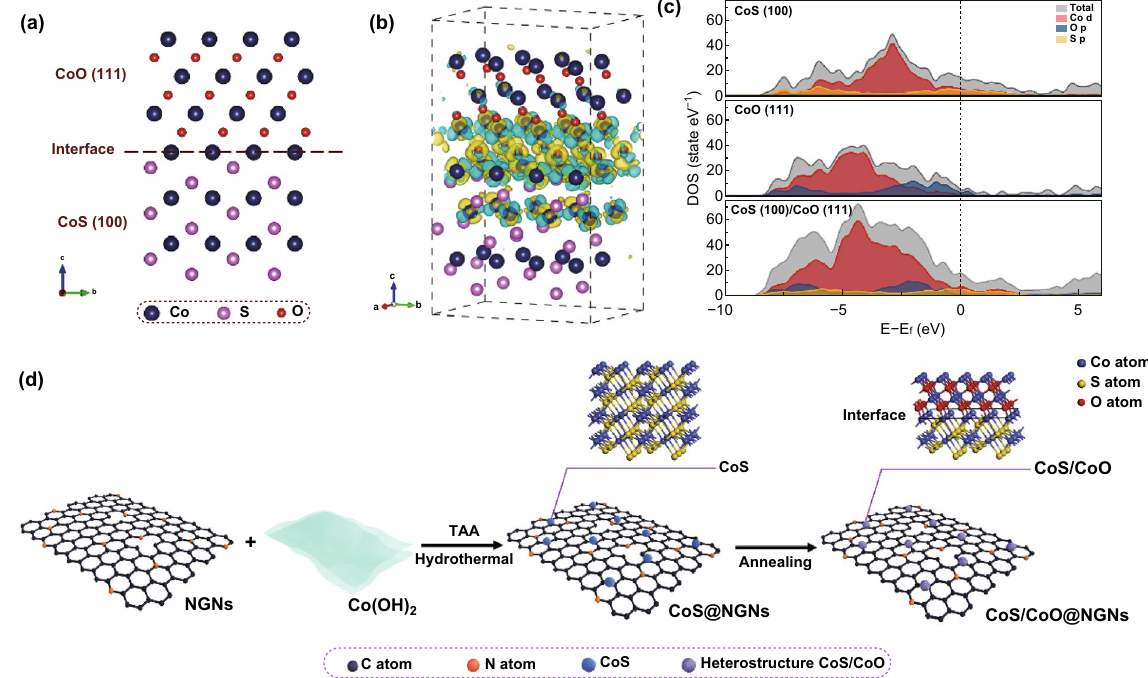
Fig. 1 a Schematic of the CoS (100)/CoO (111) heterostructure model. b Contour plots of differential charge density of the CoS (100)/CoO (111) model. The yellow and cyan regions represent the charge accumulation and charge depletion, respectively. The iso-surface level was set to be 0.008 eÅ −1 . c DOS plots of CoS (100), CoO (111) and CoS (100)/CoO (111). d Schematic illustration for the preparation of CoS/CoO@